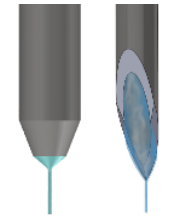
Fig. 1. Standard capillary (left) and needle emitter